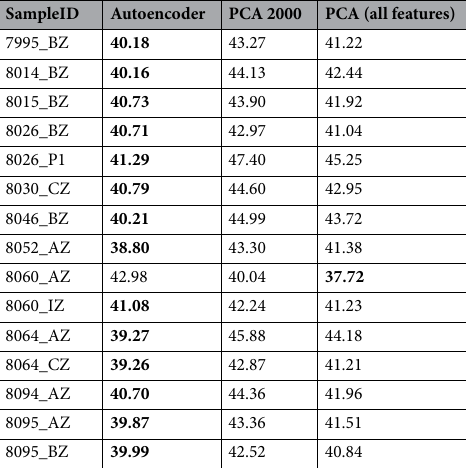
Table 5. Comparing reconstructed-original data similarity ( S score) among Autoencoder, PCA2000 and PCA approach. The lowest S score (most reconstructed-original similarity) approach is bold-highlighted.